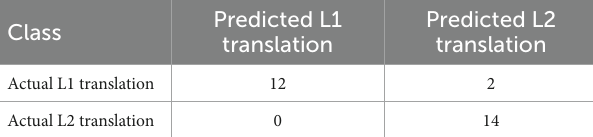
TABLE 3 Classification confusion matrix.